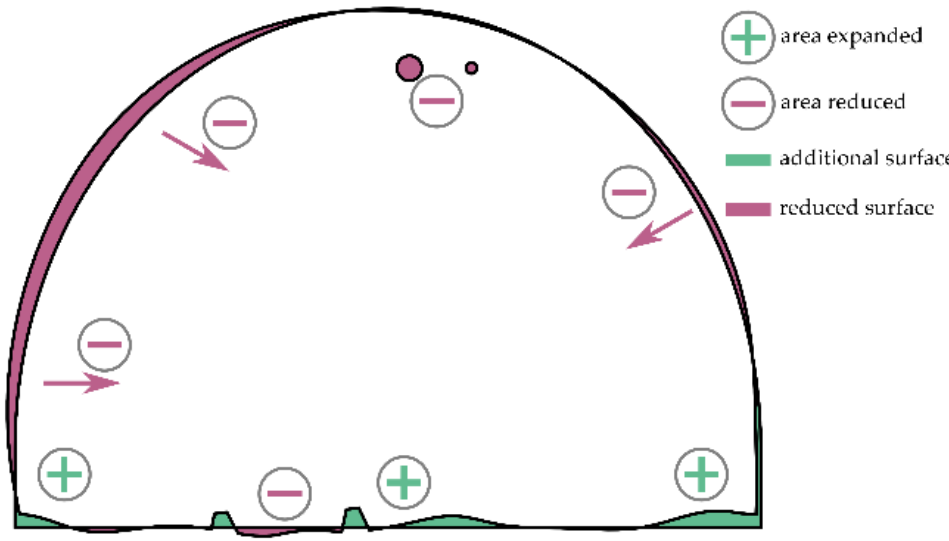
Figure 14. Differences in cross-sections between reference method and approximation by a semi- ellipse with attached straight sections; cross-section 1.2.